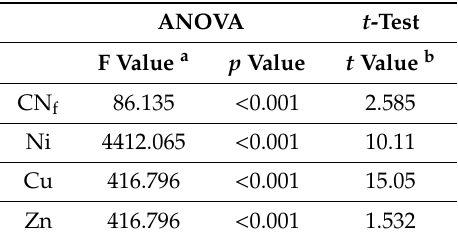
Table 2. Statistical analysis (ANOVA and t -test) for comparing the removal percentages obtained, for all pollutants, using the three bioadsorbents tested (CAB, EBGM and EAC). ANOVA